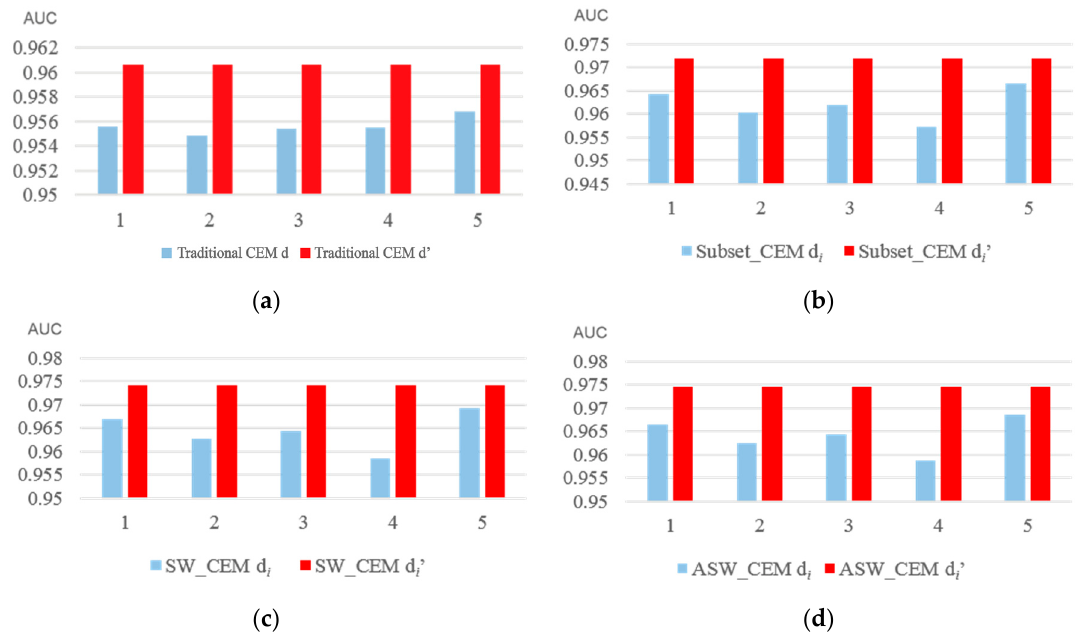
Figure 25. AUC detection results of various algorithms executing five different d and corresponding d’ generated by OSGP ( a ) CEM; ( b ) Subset CEM; ( c ) SW CEM; and, ( d ) ASW CEM.